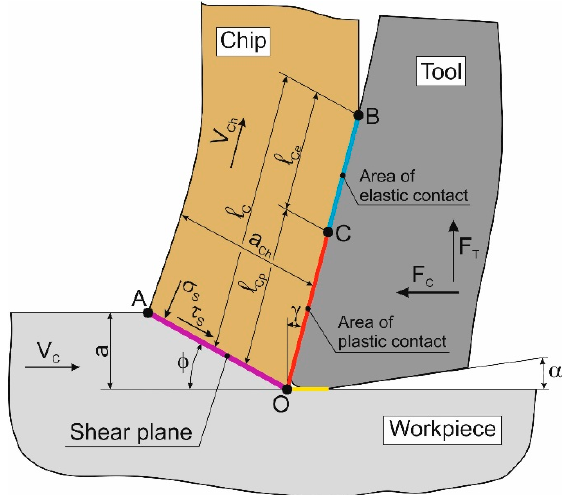
Figure 1. Layout of chip formation for the orthogonal cutting process. (The following symbols are used in the figure: V C —cutting speed; V Ch —chip speed; a —undeformed chip thickness; a Ch —chip thickness; σ S and τ S —normal and tangential stress, respectively; l Cp and l Ce —the length of the plastic and elastic contact zone, respectively; α —tool clearance angle; F C and F T —cutting and thrust force, respectively).